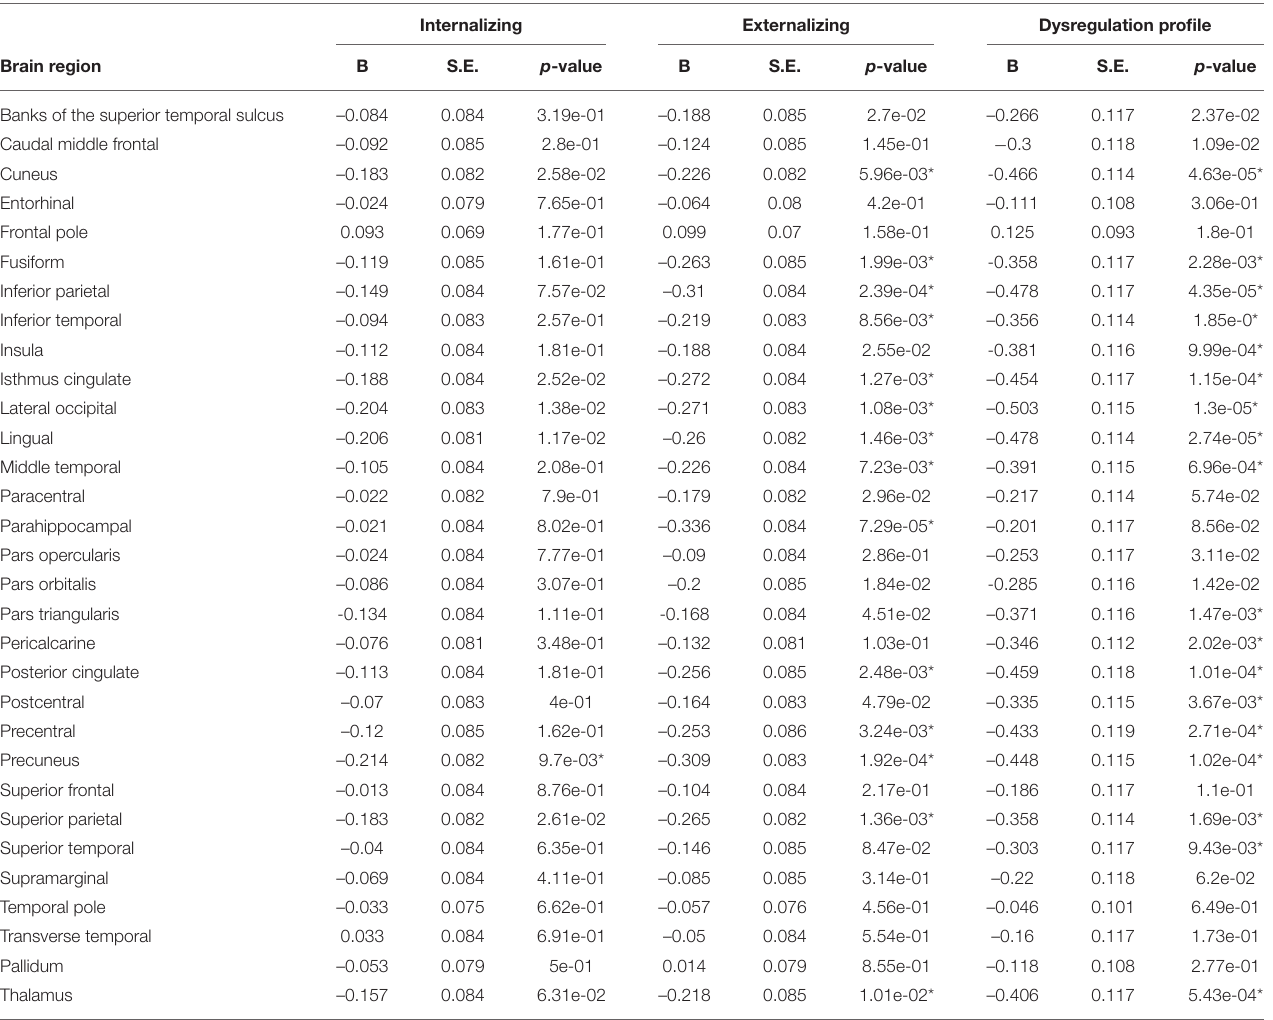
TABLE 4 | Exploratory (sub-)cortical volume model